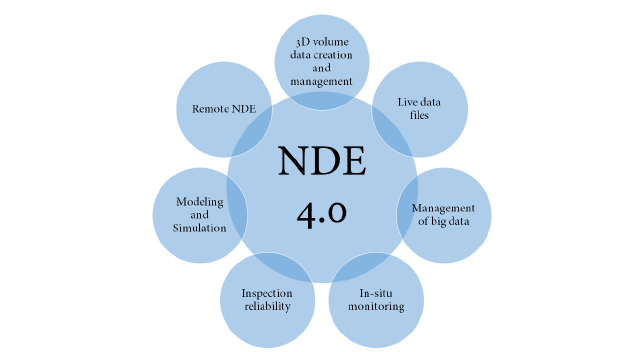
Figure 8. Aspects of new trends in NDE 4.0 (After [43]).